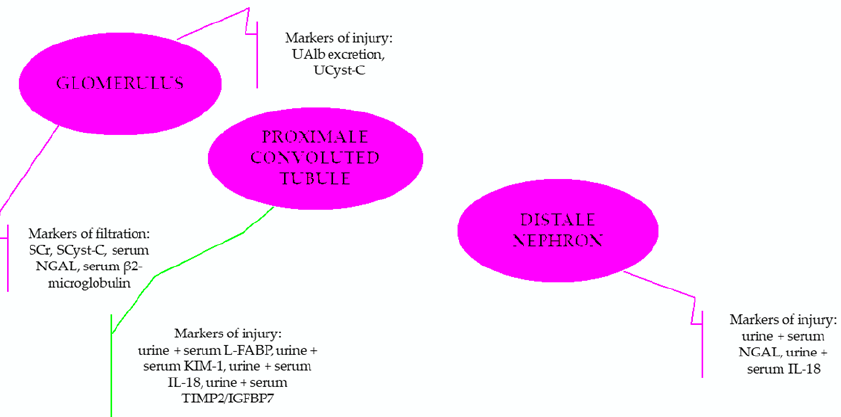
Figure 4. The role of novel biomarkers in identifying the site of AKI insult. Notes: IGFBP7 = insulin- like growth factor-binding protein 7; IL-18 = interleukin-18; KIM-1 = kidney injury molecule-1; L-FABP = liver-type fatty acid-binding protein; NGAL = neutrophil gelatinase-associated lipocalin; SCr = serum creatinine; SCyst-C = serum cystatin-C; TIMP2 = tissue inhibitor of metalloproteinase-2; UAlb = urine albumin; UCyst-C = urine cystatin-C (Modified after [69,101]).